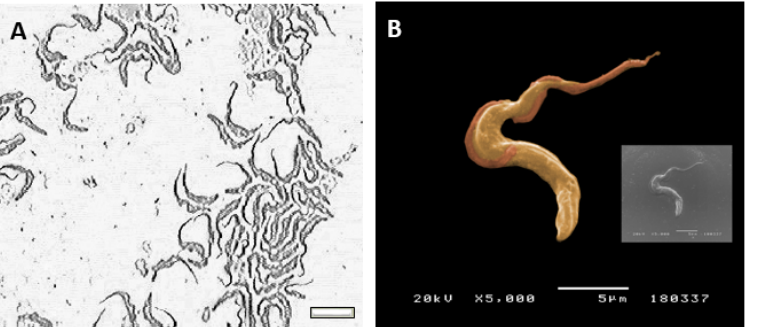
Figure 1. Trypomastigote forms of Trypanosoma brucei brucei . Culture-derived parasites were morphologically evaluated under an inverted light microscope ( A , size bar—10 μ m, ×400 magnification) and after metalization topographically analyzed by SEM ( B ). Image B was artificially coloured using the GIMP2.10.0 software.